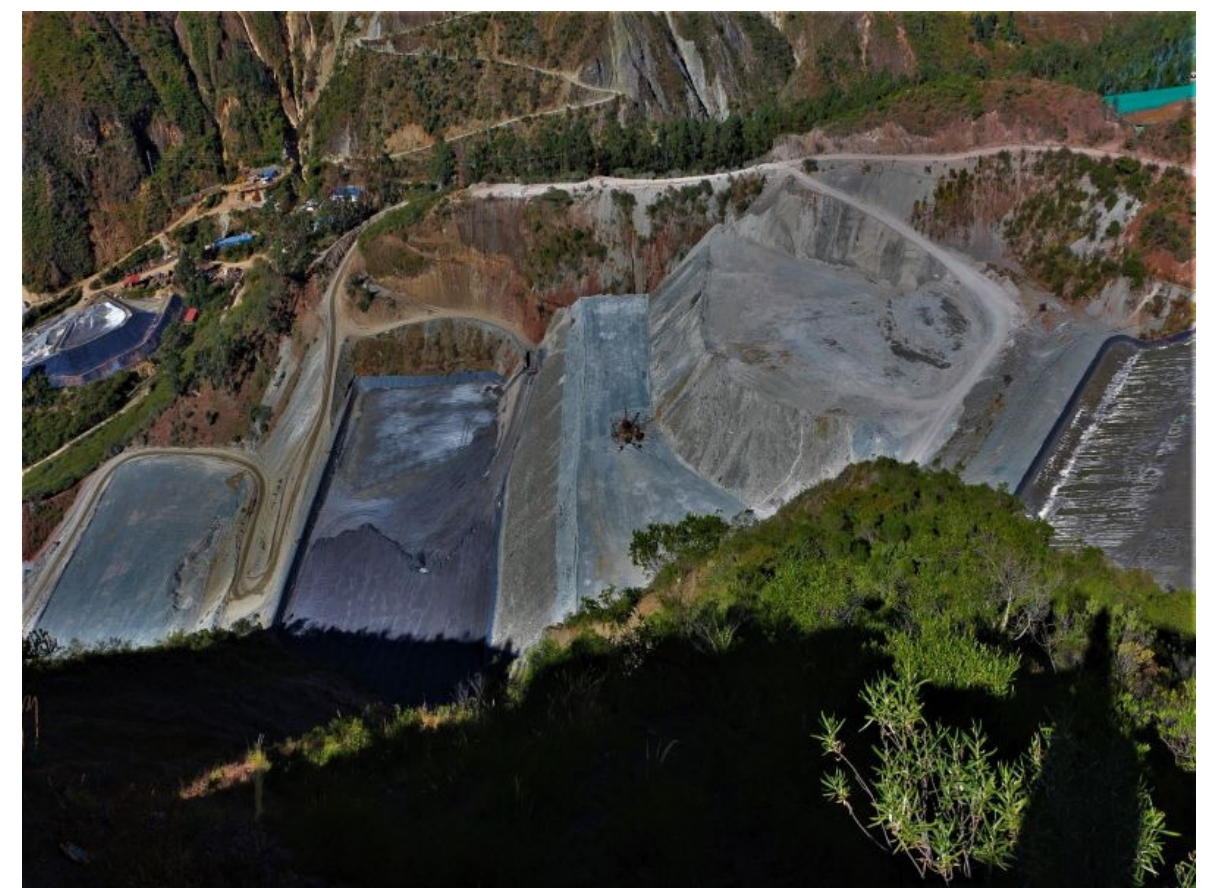
Figure 65. Curaubamba Filtered TSF–Typical Cross Section [38,39].